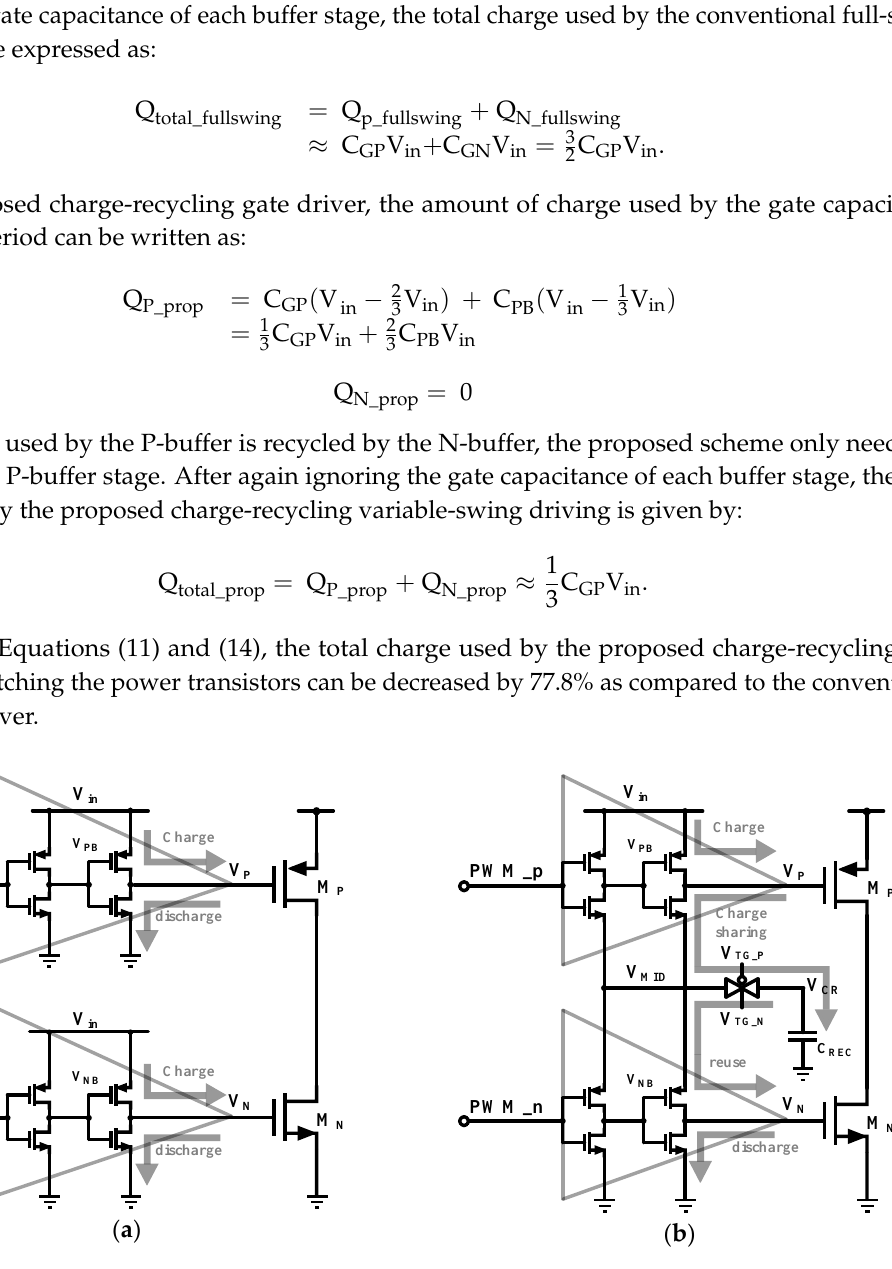
Figure 4. Gate driver operation: ( a ) conventional full-swing gate driver and ( b ) proposed charge- recycling gate